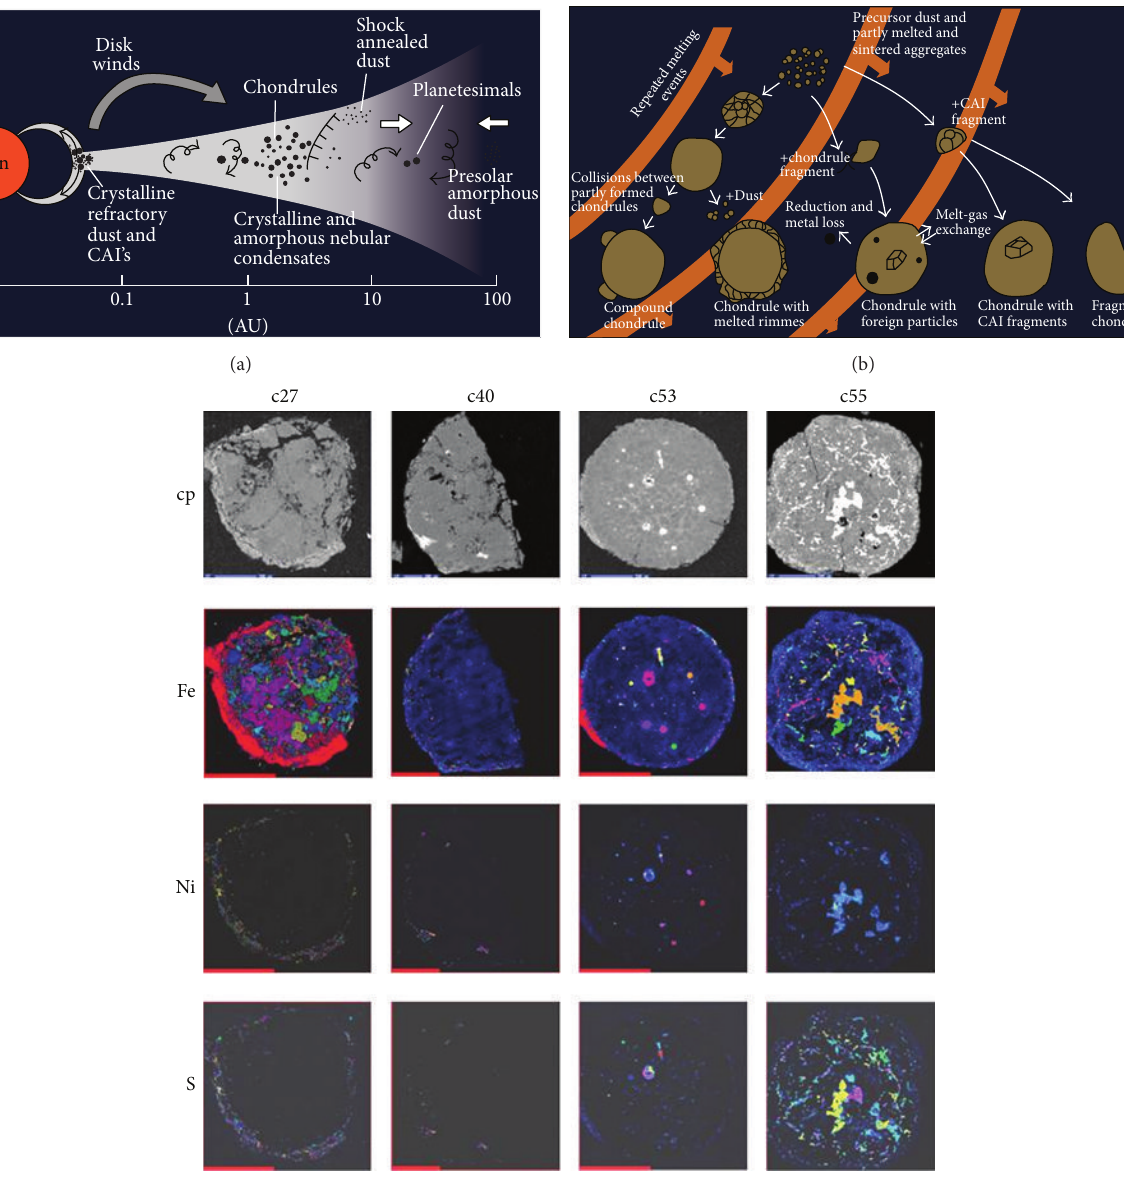
Figure 8: Schematic model of formation of chondrules and calcium-aluminium inclusions CAIs. (a) Protoplanetary disk. (b) Chondrule types with different morphologies and internal structures (adapted from Scott [43]). (c) Scanning electron microscopy images of individual chondrules from the Allende meteorite, showing the different morphologies, internal structures, and Fe, Ni, and S compositions. Numbers refer to laboratory sample identifications (Urrutia-Fucugauchi et al.